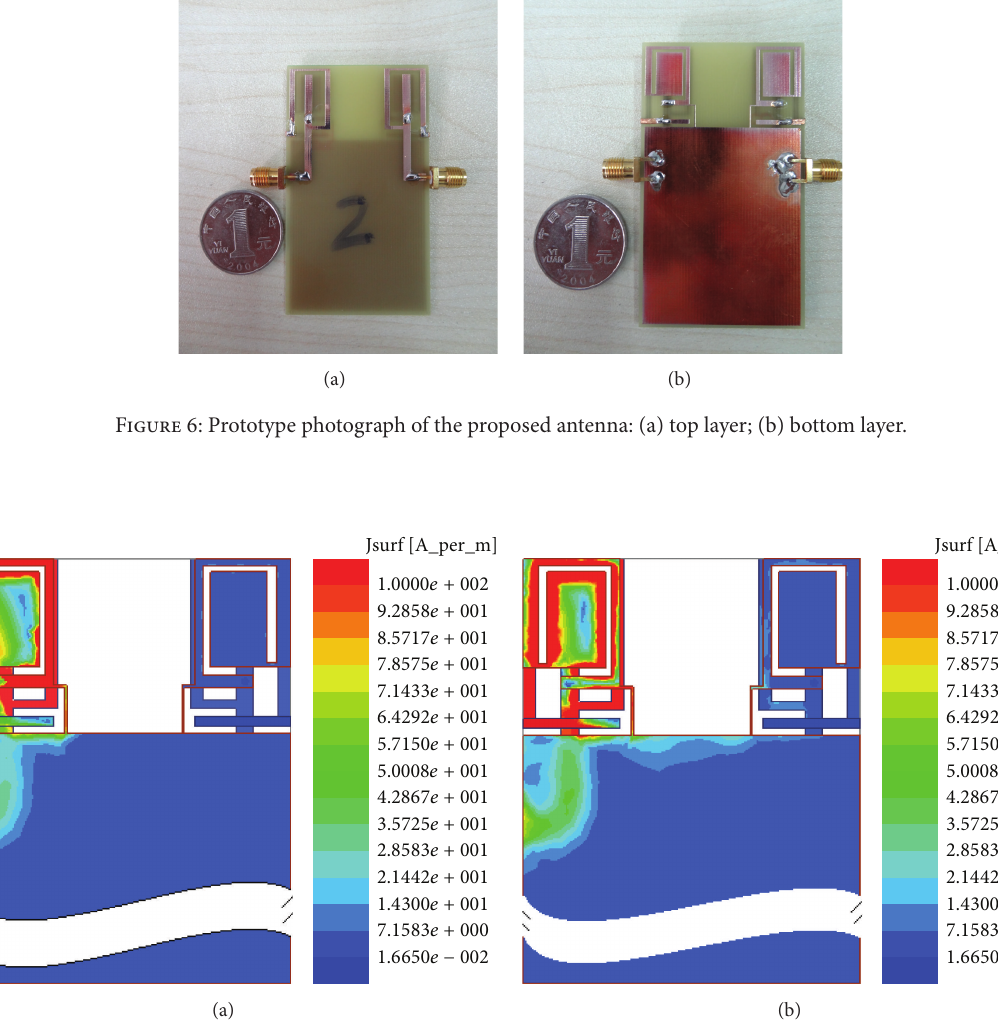
Figure 7: Simulated surface current distributions at (a) 700 MHz and (b) 750